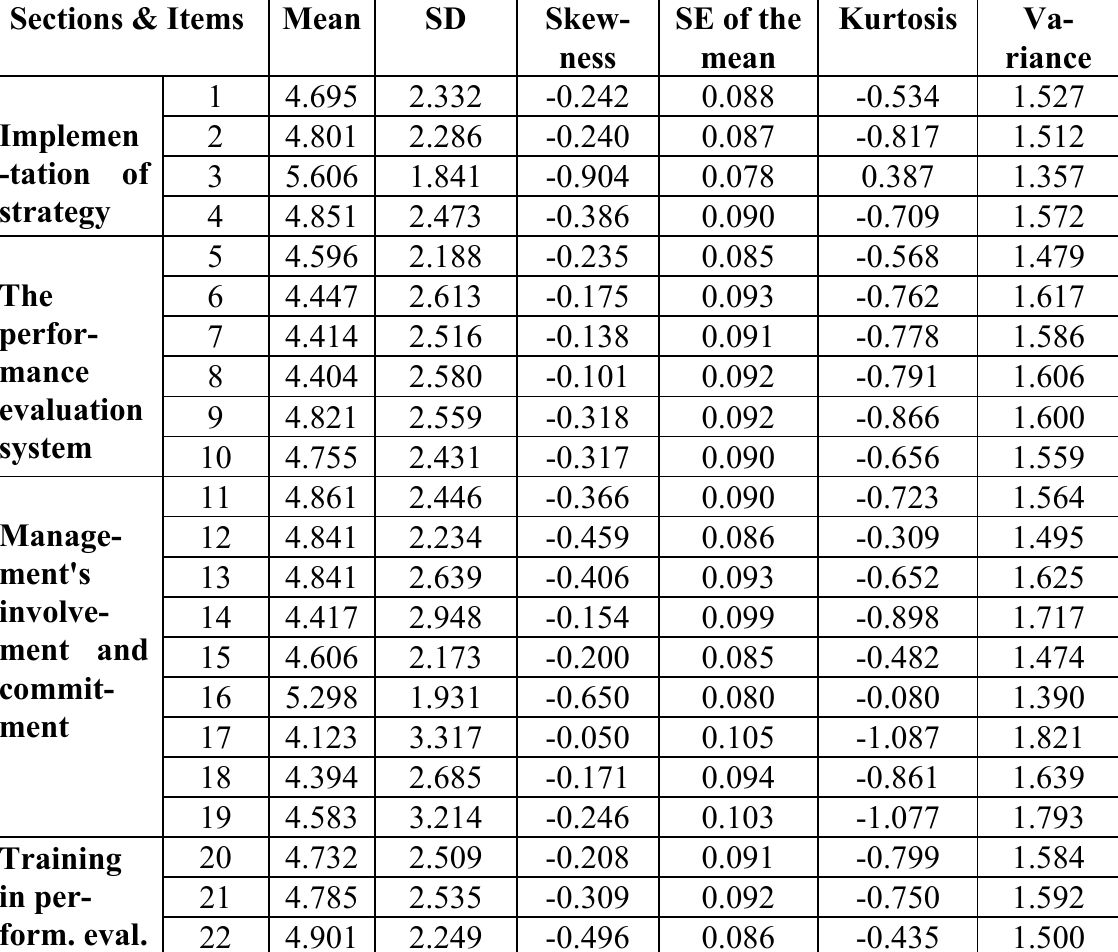
Descriptive statistics of the questionnaire: Profile of